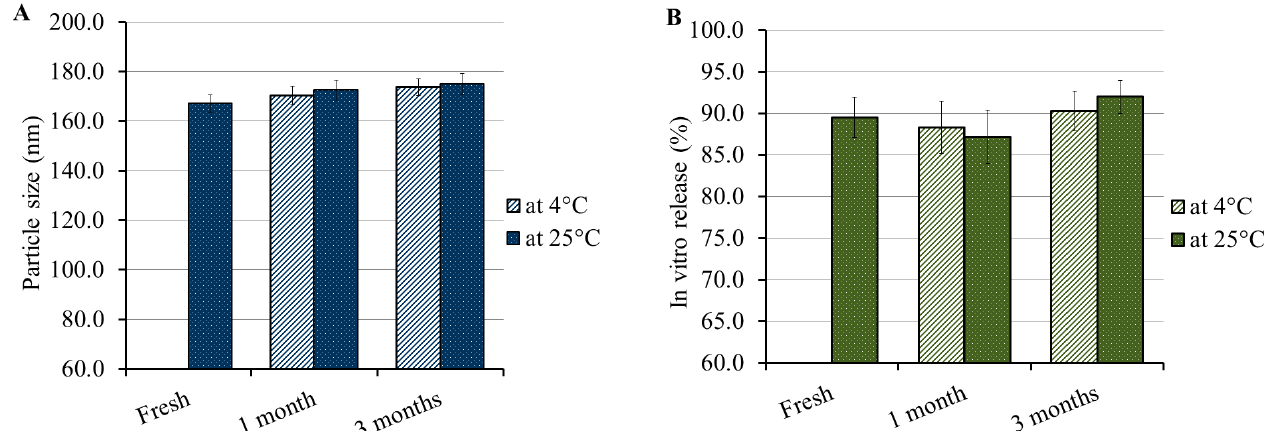
Figure 9. Stability study of optimized PGZ-loaded NE following storage for 1 and 3 months at two